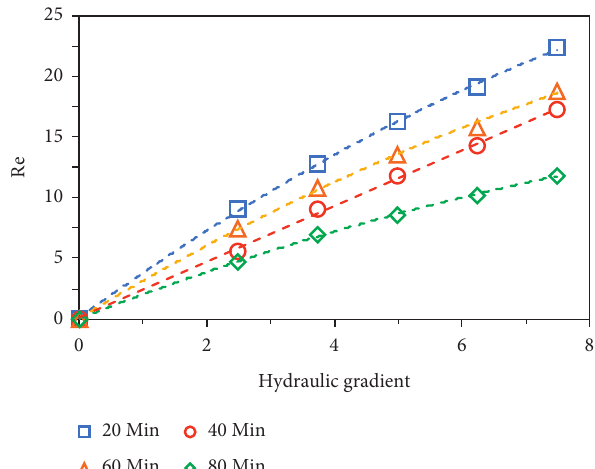
Figure 10: Plot of Re and hydraulic gradient for PUPM 8-H during the 20-, 40-, 60-, and 80-minute clogging